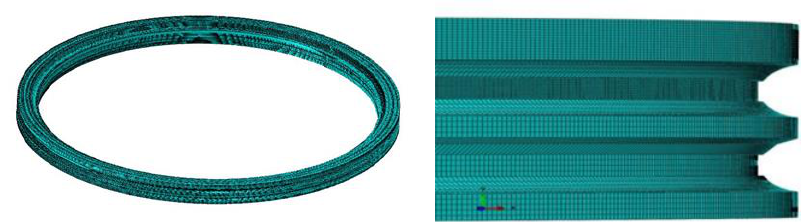
Figure 2. Finite element model and local refinement of the inner ring.